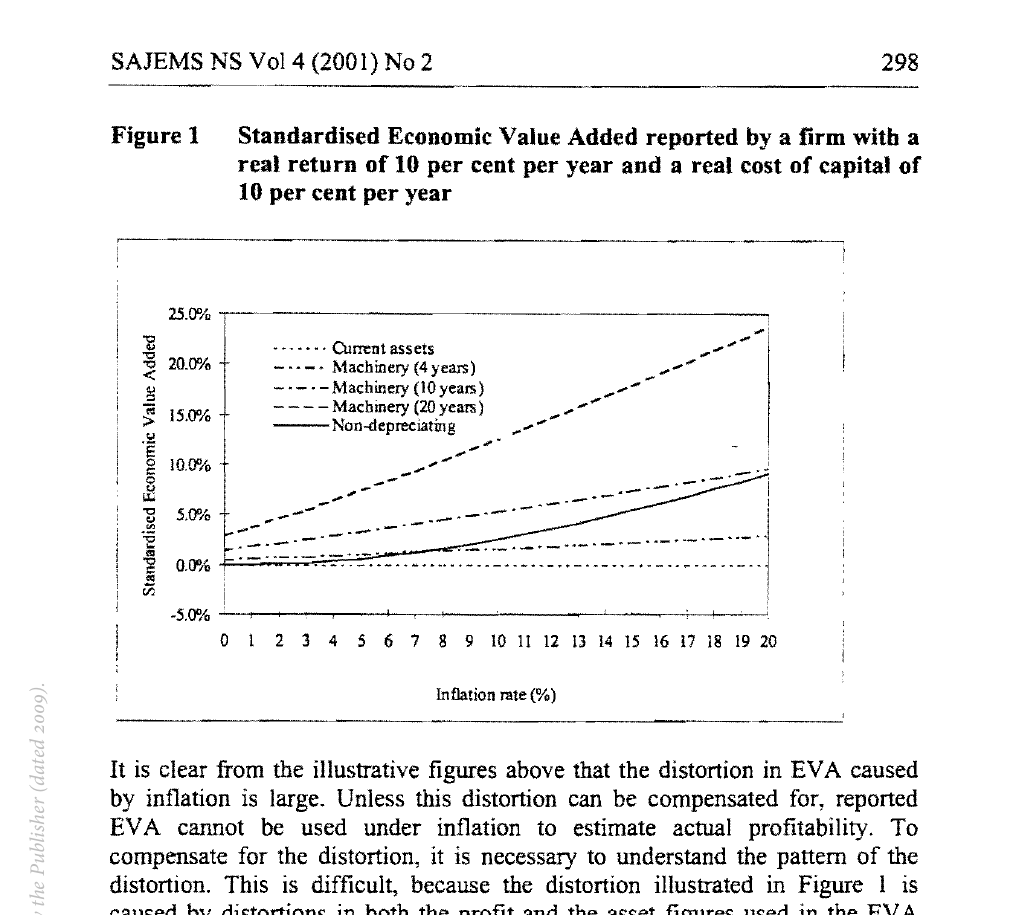
Figure 1 Standardised Economic Value Added reported by a firm with a real return of 10 per cent per year and a real cost of capital of 10 per cent per